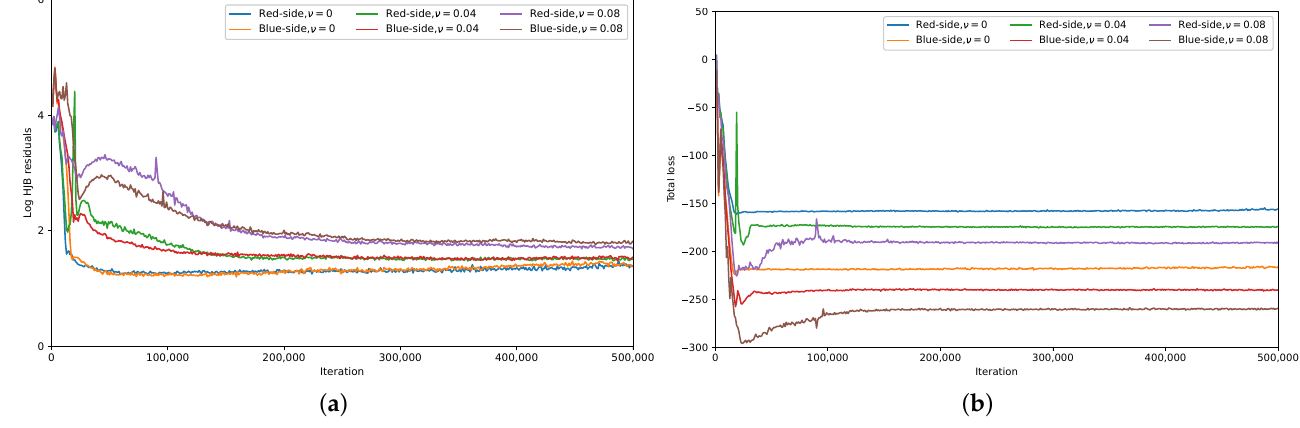
Figure 4. Convergence analysis. ( a ) Convergence of HJB residual; ( b ) Convergence of total